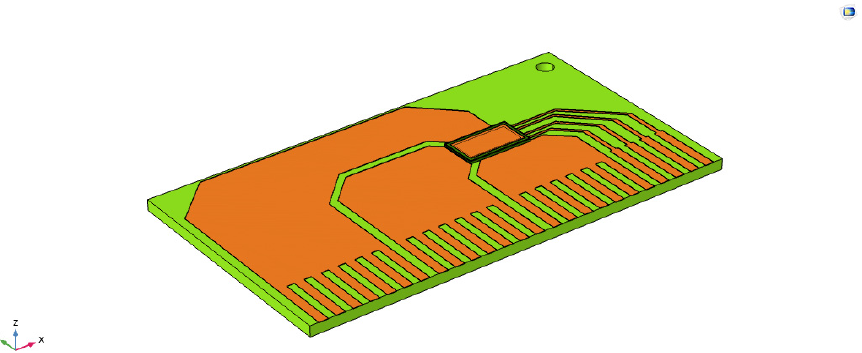
Figure 8. Implemented geometry for Rth,j-a computation with printed circuit board and package.